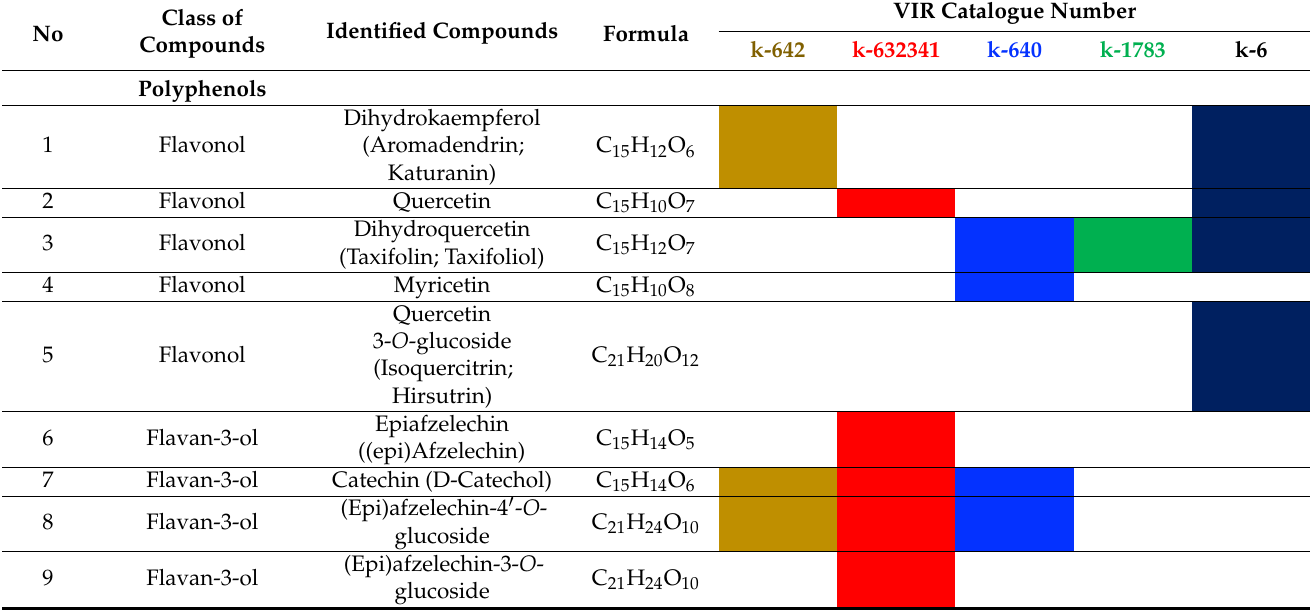
Table 3. Distribution of bioactive substances in accessions of V. unguiculata.